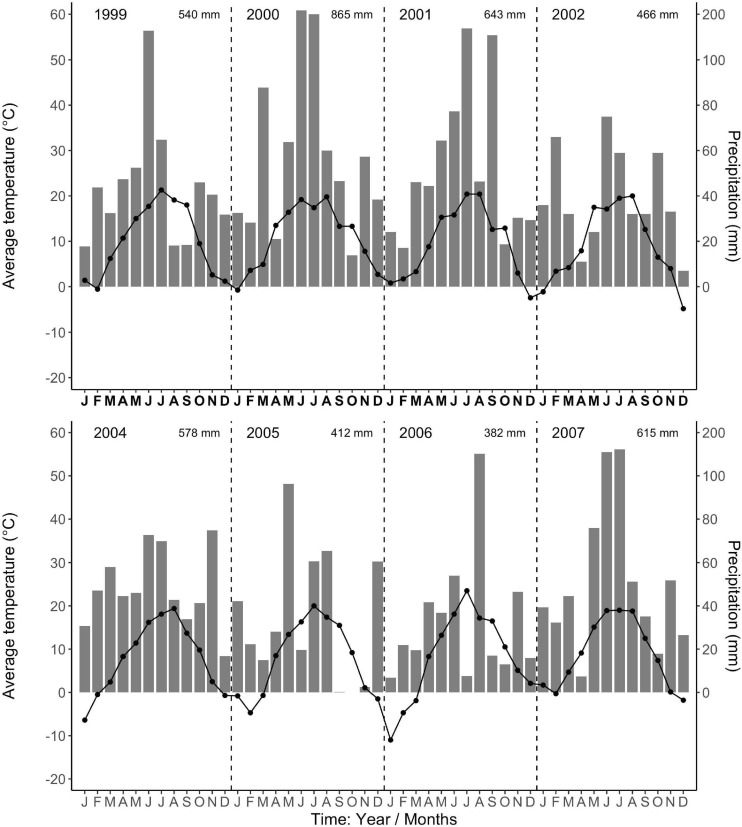
Average monthly air temperatures (°C, point-line) and total monthly precipitation (mm, gray bars) from the Forestry Experimental Station, Siemianice, Poland (1999–2007). The temperature and precipitation data are in fixed proportions, 10°C corresponding to a precipitation of 20 mm, allowing the characterization of periods with indications of water limitation (Gaussen and de Phillips, 1958; Walter and Lieth, 1960). Months where the temperature point exceeds the precipitation bar indicate possible deficit in water availability. The total annual precipitation is stated in the upper right corner for each year. Data for the year 2003 are not available.